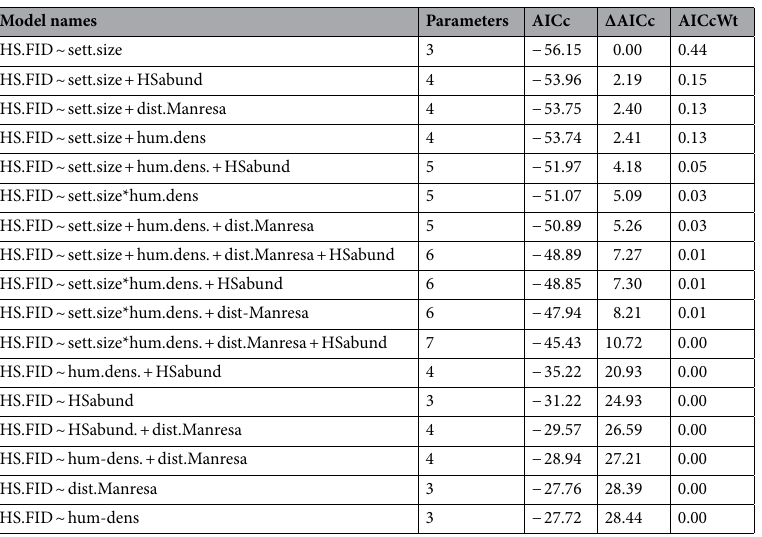
Table 2. Models relating human population density (hum.dens), settlement size (sett.size), distance to Manresa (dist.Manresa), and House Sparrow abundance (HSabund.) with sparrow FIDs (HS.FID) in 26 settlements of the region of Manresa,